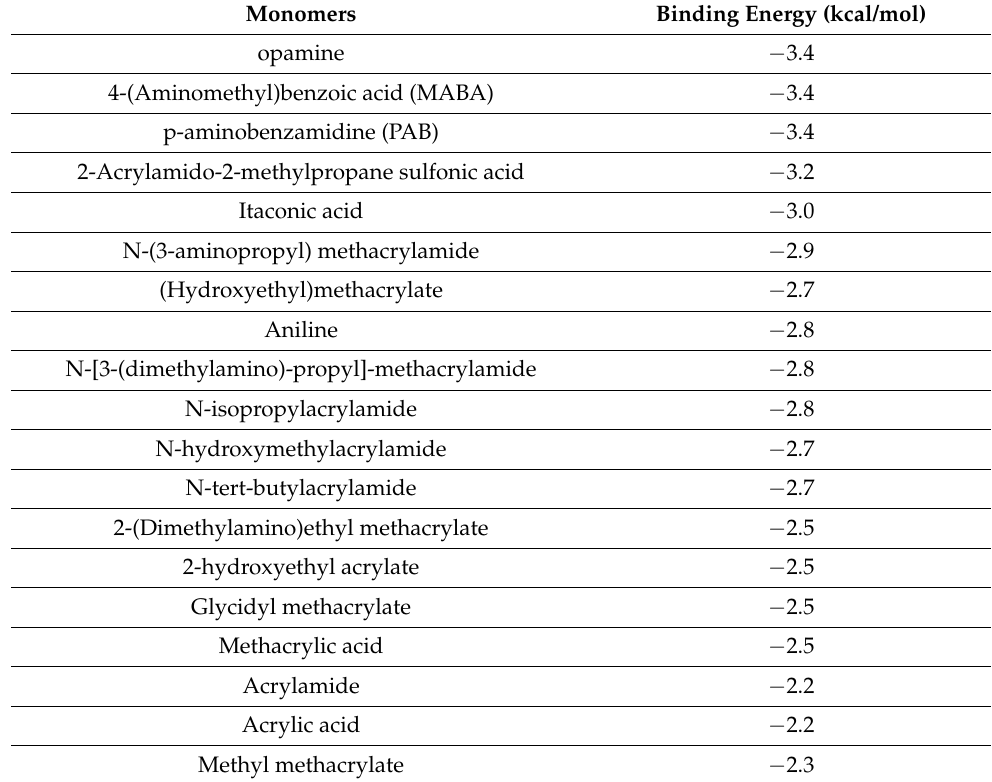
Table 2. Virtual screening of a library of functional monomers for rationally predicting an effective molecularly imprinted polymers (MIP) design. A ranked list of docked monomers is arranged in ascending order of binding energy. Higher negative values (kcal/mol) indicate better binding affinity. Monomers Binding Energy (kcal/mol) opamine − 3.4 −